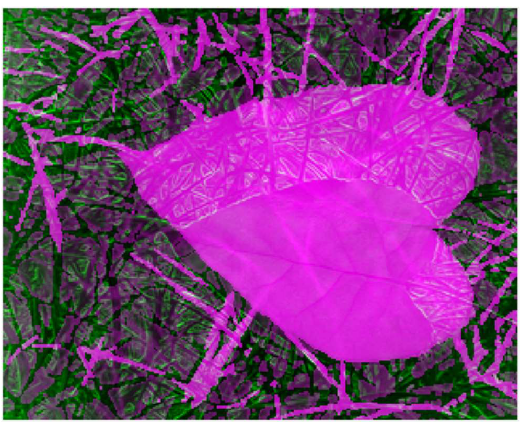
Figure 7. The real world image pair registered result by MIND.